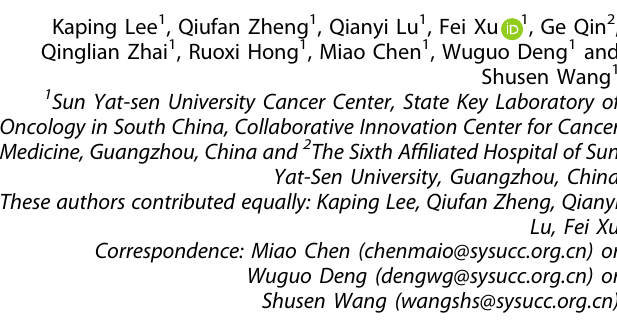
Fig. 1 CPSF4 promotes triple negative breast cancer metastasis by upregulating MDM4. a , b Both MDA-MB-231 and SUM-159PT TNBC cells were transfected with CPSF4 shRNA and overexpression lentivirus, respectively. The cells above were used to perform transwell migration